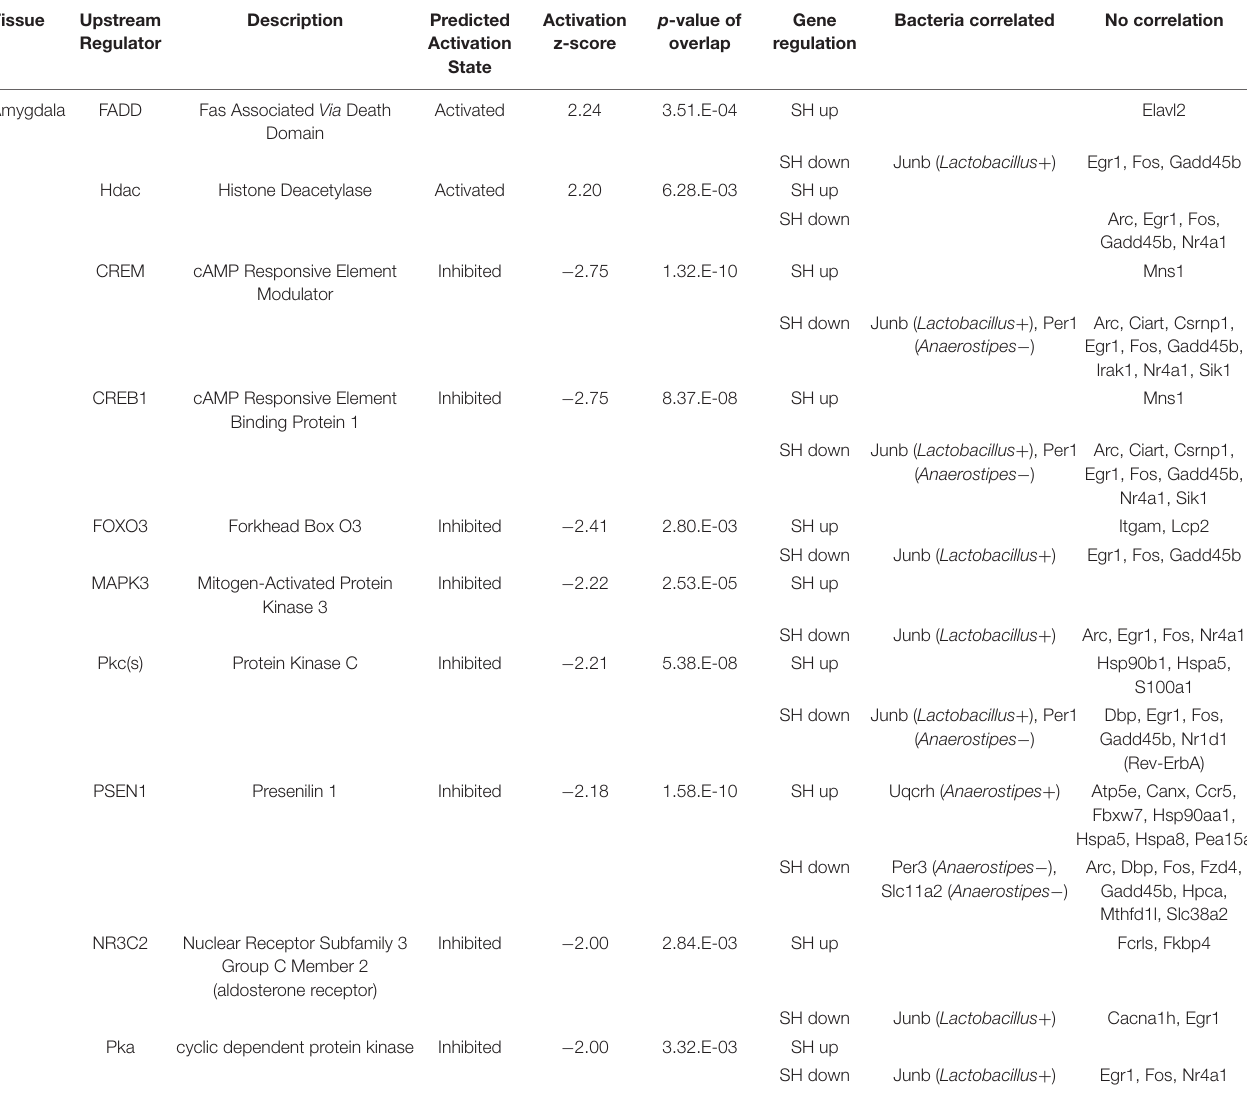
Shaded columns mark the upstream regulators related to cyclic adenine monophosphate (cAMP)